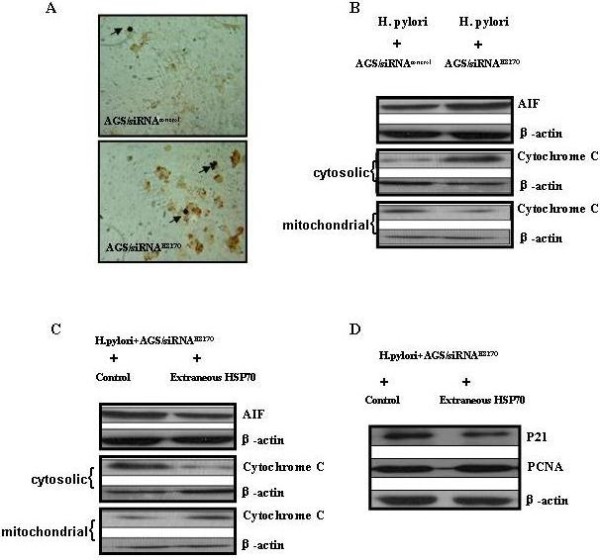
Effects of endogenous or exogenous HSP70 on apoptosis in AGS cells with H. pylori infection. (A) Representative TUNEL staining of AGS cells transfected with HSP70 siRNA or control vector following incubation with H. pylori for 48 hours. An increase in the number of TUNEL-positive cells (brown-stained nuclei, black arrows) was evident in HSP70 siRNA transfected cells. (B) Immunoblotting analyses were performed to determine the target pro-apoptotic proteins expression in HSP70 siRNA transfected AGS cells with H. pylori infection.(C)&(D) Excellular HSP70 (50 ng/ml) incorporated into the incubation medium of HSP70 siRNA transfected AGS cells and H. pylori (1:200) for 48 h. The function of exogenous HSP70 on the target pro-apoptotic proteins, as well as p21 and PCNA were confirmed by immunoblotting. β-actin was used as an internal control.